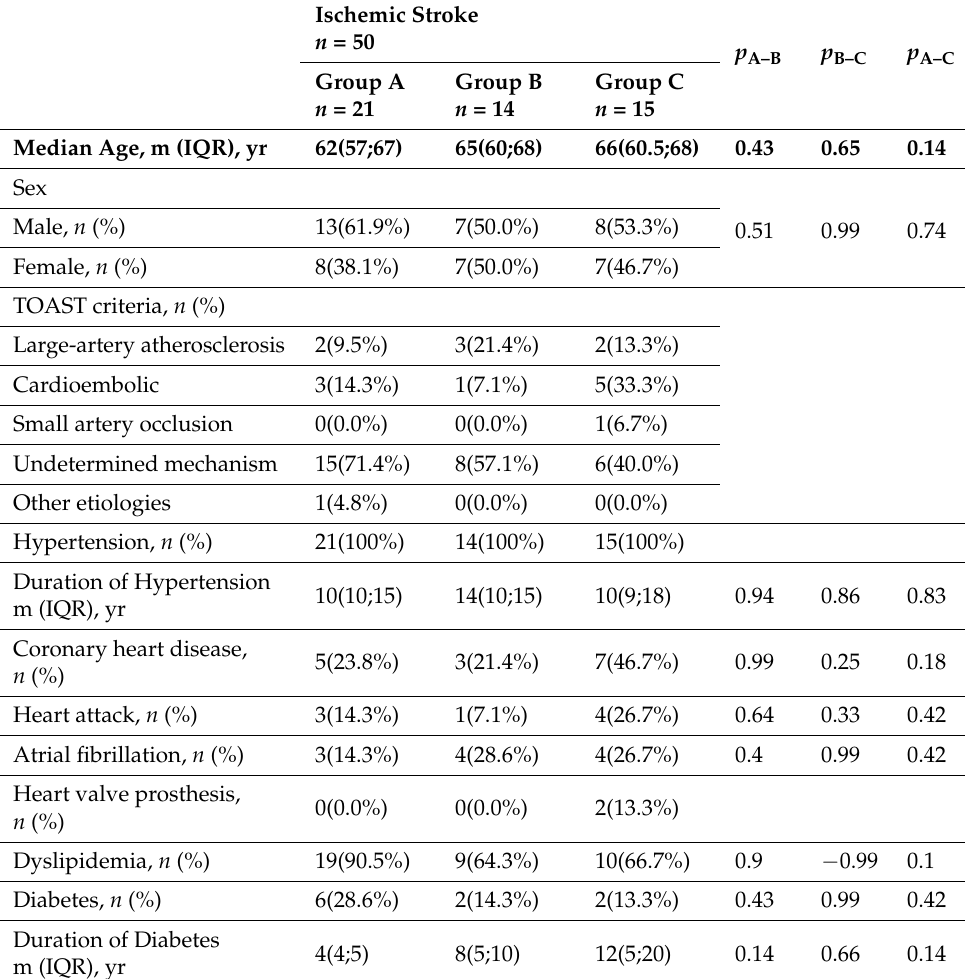
Table 1. Baseline characteristics of the ischemic stroke